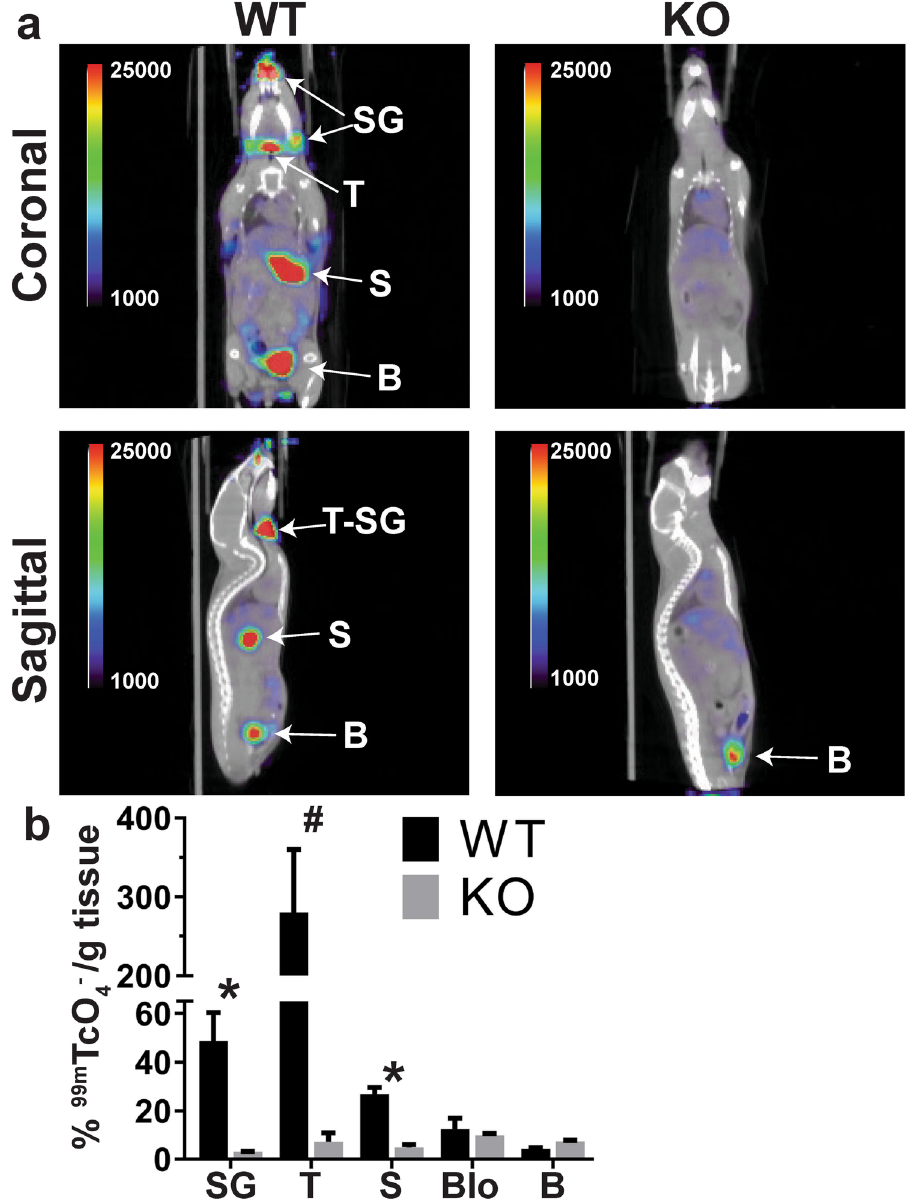
Figure 3. Lack of active accumulation of a NIS substrate in NIS KO mice. ( a ) SPECT/CT analysis of 3-month- old female WT and NIS KO mice fed a CD (coronal and sagittal views). WT mice accumulate 99m TcO 4 − in the thyroid (T), salivary glands (SG), and stomach (S). NIS KO mice accumulate 99m TcO 4 − only in the bladder (B). Images are displayed as % injected dose/cc. ( b ) Quantitation of 99m TcO 4 − in the corresponding dissected organs 3 hours after injection of the isotope (n = 2–3) with gamma well counting. Activity is expressed as % injected dose/gram of tissue. T = thyroid, SG = salivary gland, S = stomach, Blo = blood, B = bladder. * Indicates p < 0.05, # p <